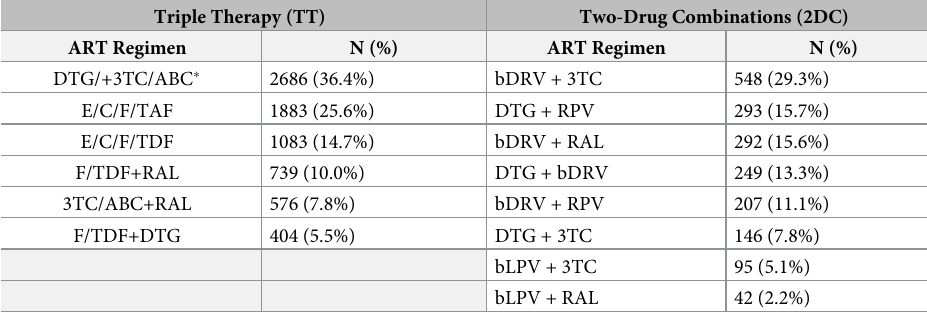
Table 1. Antiretroviral therapy distribution, overall sample, by therapy